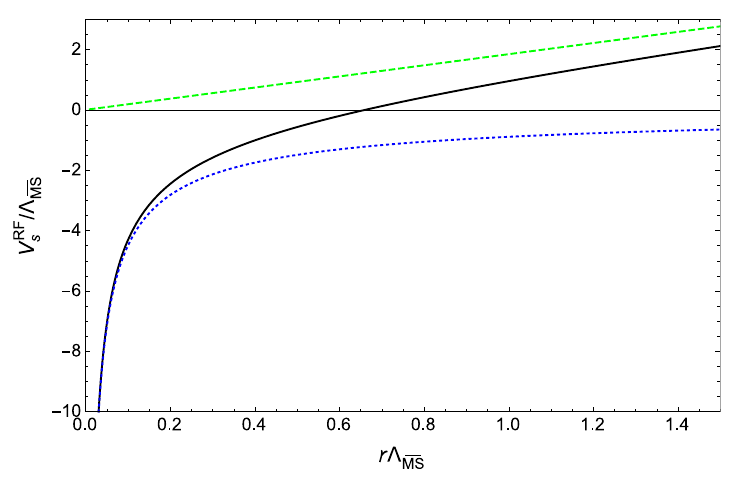
Figure 1 . Renormalon free singlet potential V RF V C ( r ) = (cid:3) is shown by the blue dotted line, and the linear contribution C 1 r= (cid:3) MS shown by the green dashed line. The results are obtained with regularization method I [eq. (2.19)].